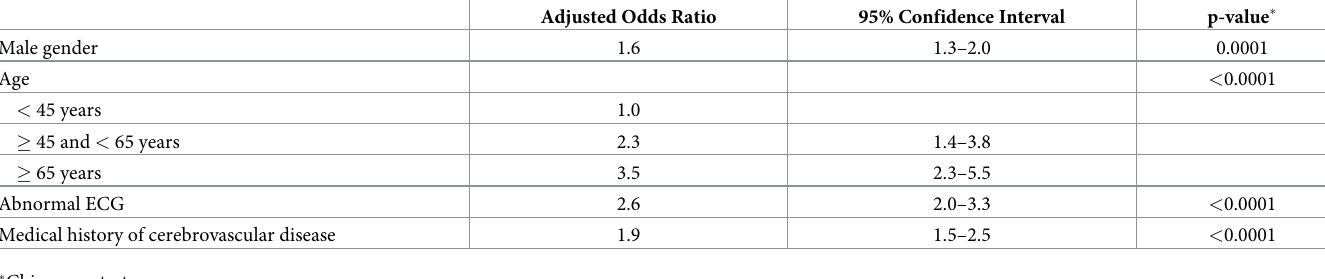
Table 3. Risk factors for severe short-term outcomes within 10 days at logistic multivariate regression (stepwise